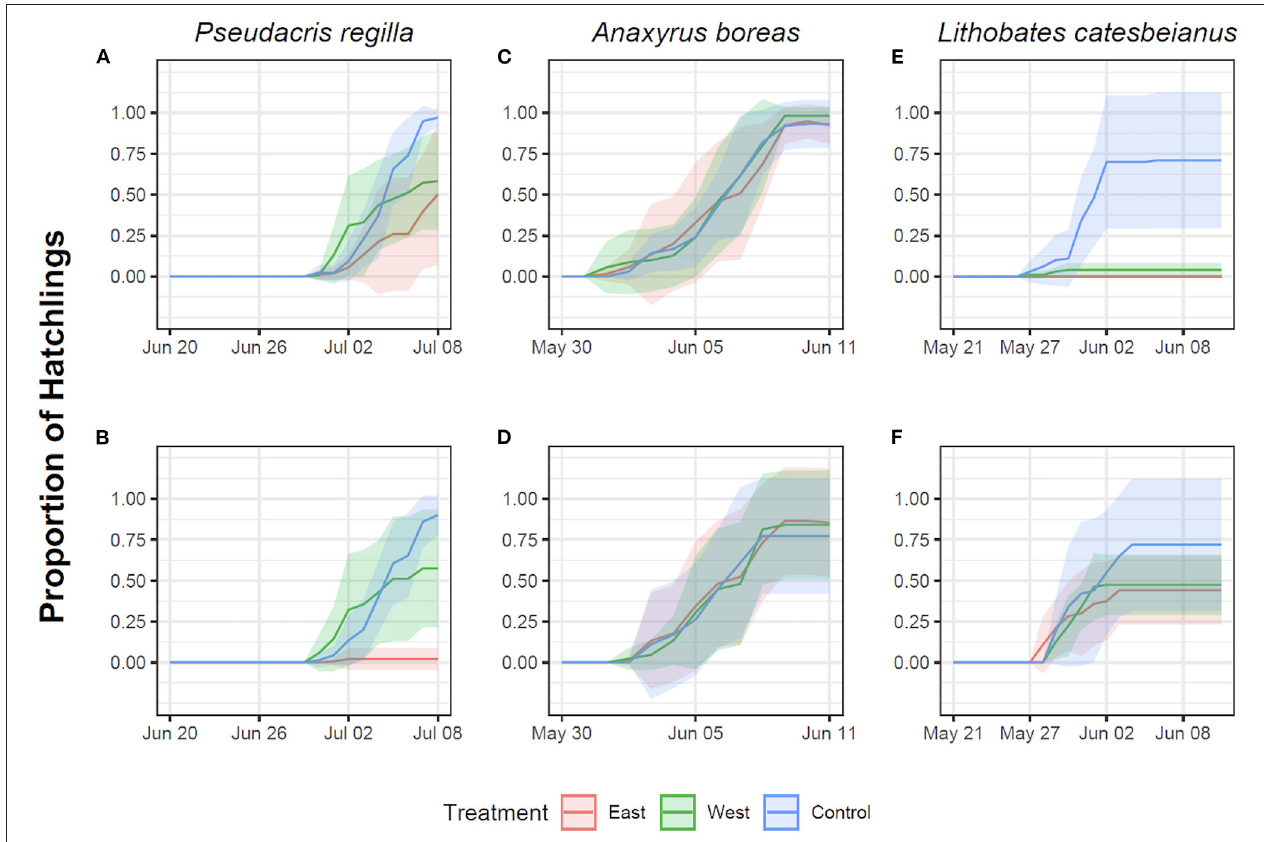
FIGURE 2 | Proportion of hatchlings in Pseudacris regilla , Anaxyrus boreas , and Lithobates catesbeianus after exposure of eggs to different chytrid treatments. Red represents exposure to the East strain, green represents exposure to the West strain, and controls are indicated in blue. First row represents Early exposure (Gosner stage 12) for Pseudacris regilla (A) , Anaxyrus boreas (C) and Lithobates catesbeianus (E) . Second row represents Late exposure (Gosner stage 18) for Pseudacris regilla (B) , Anaxyrus boreas (D) and Lithobates catesbeianus (F)